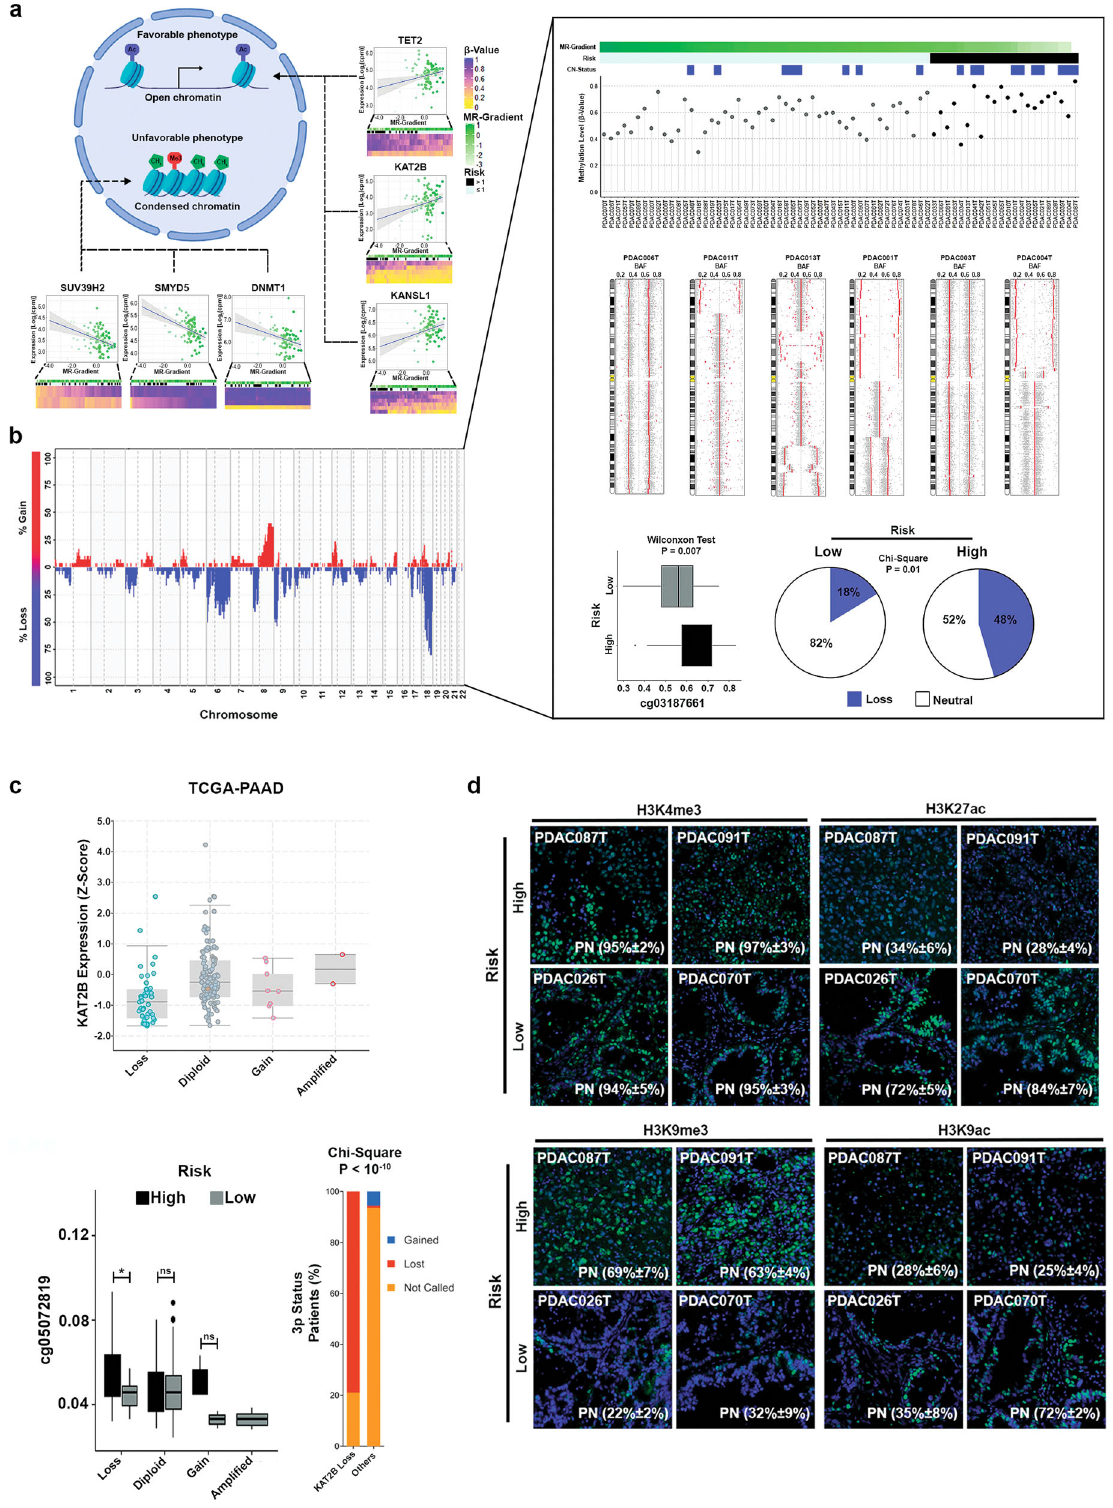
Fig. 5 Identi fi cation of key epigenetic modi fi ers related with the PDAC prognosis phenotype. a One hundred forty-nine chromatin modi fi ers correlated with the MR-Gradient at transcriptional level. Speci fi cally, SUV39H1/H2 and KAT2B, two antagonist writers of the H3K9 residue were identi fi ed correlating negatively and positively with the MR-Gradient, respectively. b KAT2B displayed a shallow deletion in the 25% of PDX which was associated with a high-risk phenotype ( P = 0.01). Moreover, KAT2B expression levels were modulated by the balance between the shallow deletion and the methylation pro fi le. c KAT2B shallow deletion was con fi rmed in the TCGA-PAAD cohort and was signi fi cantly associated with a hypermethylation in the high-risk patients and 3p status. Error bars indicate mean ± SD. * P < 0.05. d Immuno fl uorescence analysis of H3K9me3, H3K9ac, H3K4me3 and H3K27ac, con fi rmed the polarization of SUV39H1/H2 and KAT2B into the